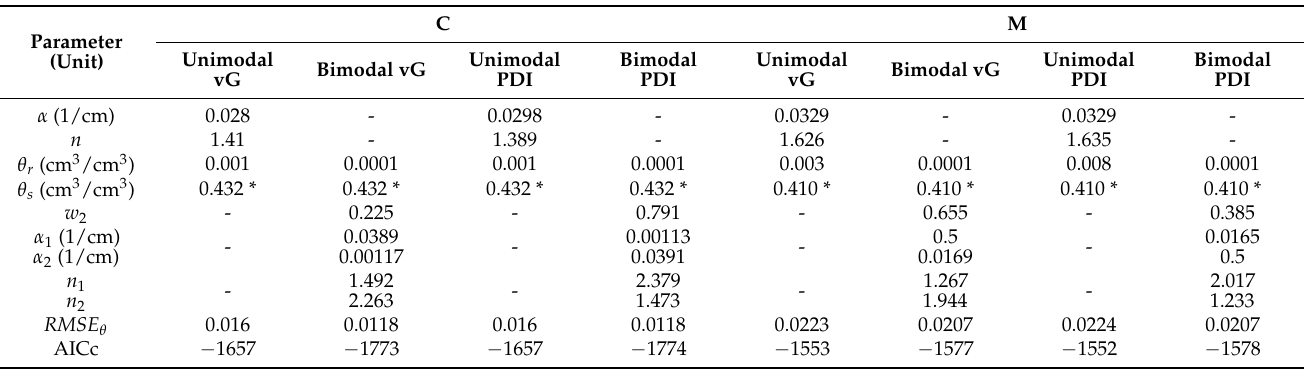
Table 2. Fitted parameters values and statistical analysis for the vG and PDI unimodal and bimodal water retention functions. Fixed values are indicated by an asterisk